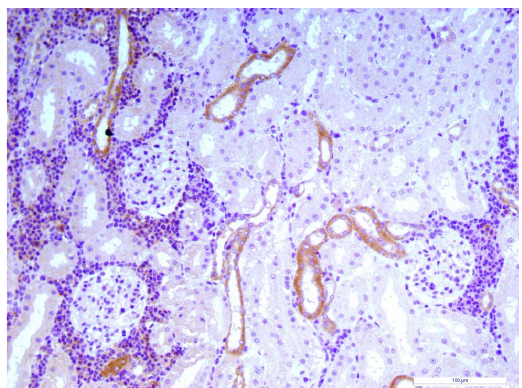
Figure 3. Cat, Kidney, Immunohistochemestry for FeMV N protein. Severe tubulointerstitial nephritis (TIN) with mononuclear cells infiltration. Epithelial cells of some cortical distal tubules showed diffuse and granular immunoreactivity for viral antigen. Mayer’s hematoxylin counterstain, final magnification × 200. Scale bar: 100 μ